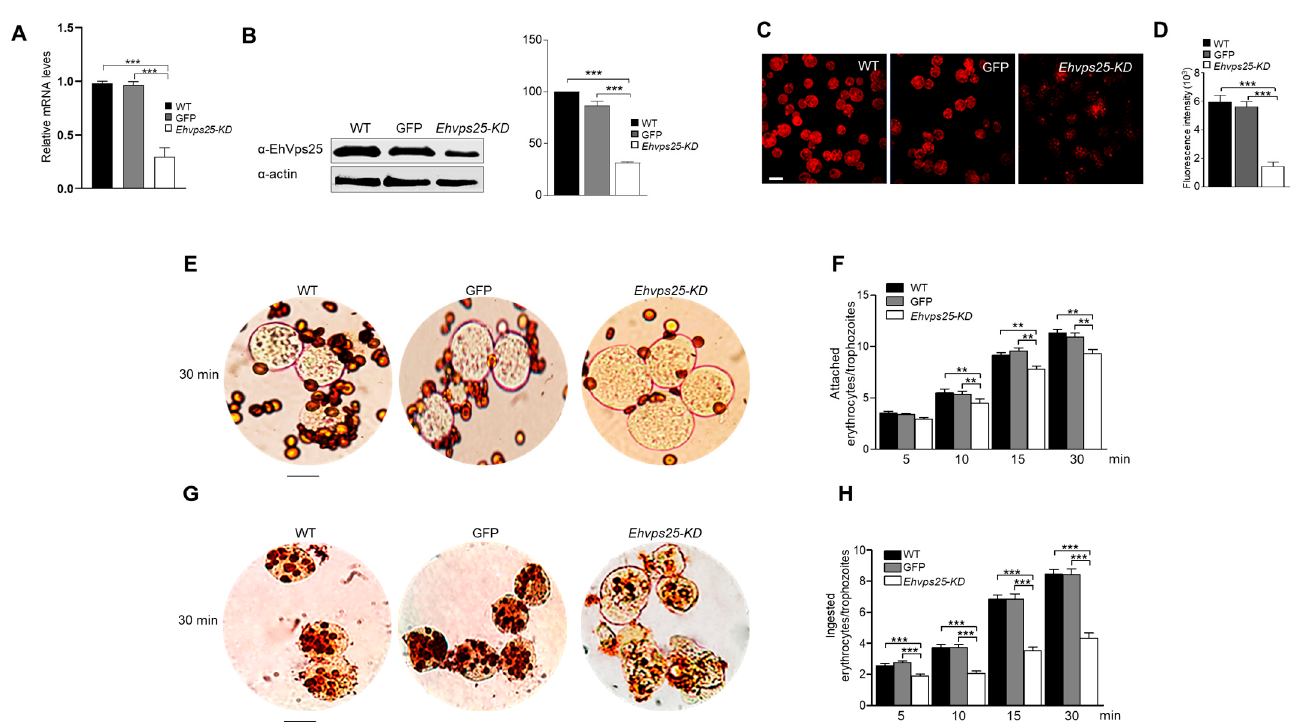
Figure 8. The phagocytic and adherence efficiency in trophozoites knocked down in the Ehvps25 gene. ( A ) Relative mRNA levels obtained by RT-qPCR assay of trophozoites in basal conditions: WT, wild-type trophozoites; GFP, green fluorescent protein, used as a control for silencing of an unrelated gene in amoeba; Ehvps25-KD , knocked-down trophozoites. ( B ) Western blot assays. ( B ) Densitometry analysis of bands in ( A ) taking actin as a loading control. ( C ) Representative image of confocal microscopy of wild-type and Ehvps25-KD trophozoites ( D ) Fluorescence intensity measured by pixels. 30 fields in each sample were analyzed to obtain the graph. ( E ) Novikoff stain of wild type and Ehvps25-KD trophozoites. ( F ) Quantification of ingested erythrocytes. ( G ) Novikoff stain of wild type and Ehvps25-KD trophozoites. ( H ) Quantification of adhered erythrocytes. Data represent the mean and standard error of the erythrocytes number counted inside 100 trophozoites. ** p < 0.01, *** p < 0.001.